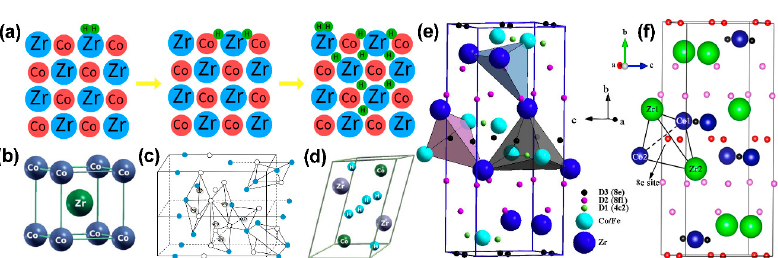
Figure 1. ( a ) Dissociation, adsorption, and permeation of hydrogen molecules; ( b ) crystal structure of ZrCo [46]; ( c ) the 6 types of tetrahedral sites and 2 types of octahedral sites of ZrCoH 3 are illustrated [10]; ( d ) crystal structure of ZrCoH 3 [46]; ( e ) crystal structure of ZrCo 0.9 Fe 0.1 D 3 [47]; ( f ) structure of ZrCoH 3 [48].